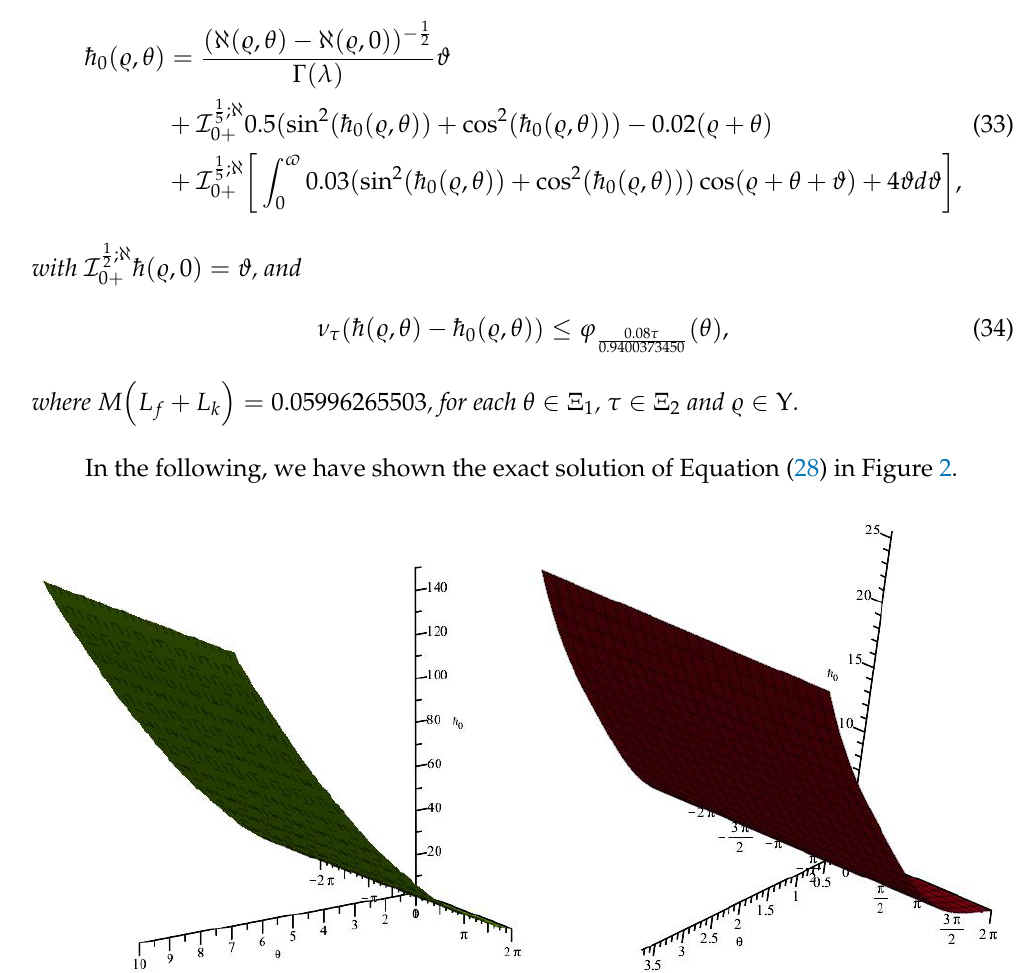
Figure 2. Graphic representation of the exact solution of Equation (28) for different values. ( a ) The exact solution of stochastic fractional nonlinear Volterra-IDE for θ ∈ ( 1,10 ) . ( b ) The exact solution of stochastic fractional nonlinear Volterra-IDE θ ∈ ( 1 , 15 10 4 ) .